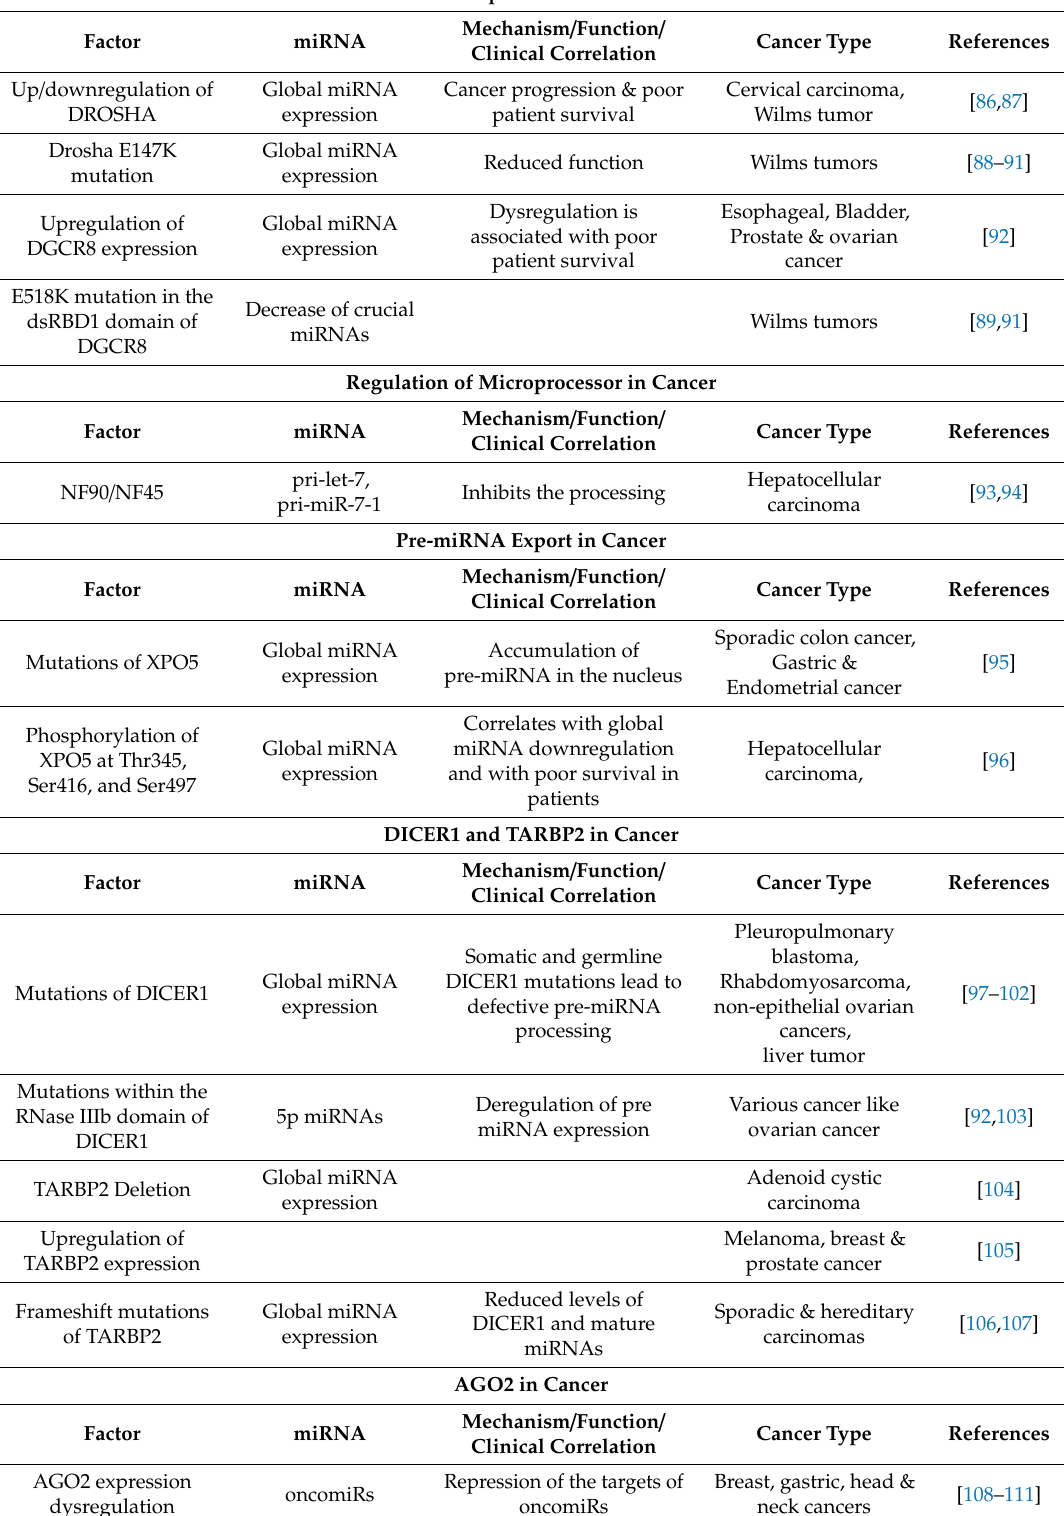
Table 2. Dysregulation of miRNA